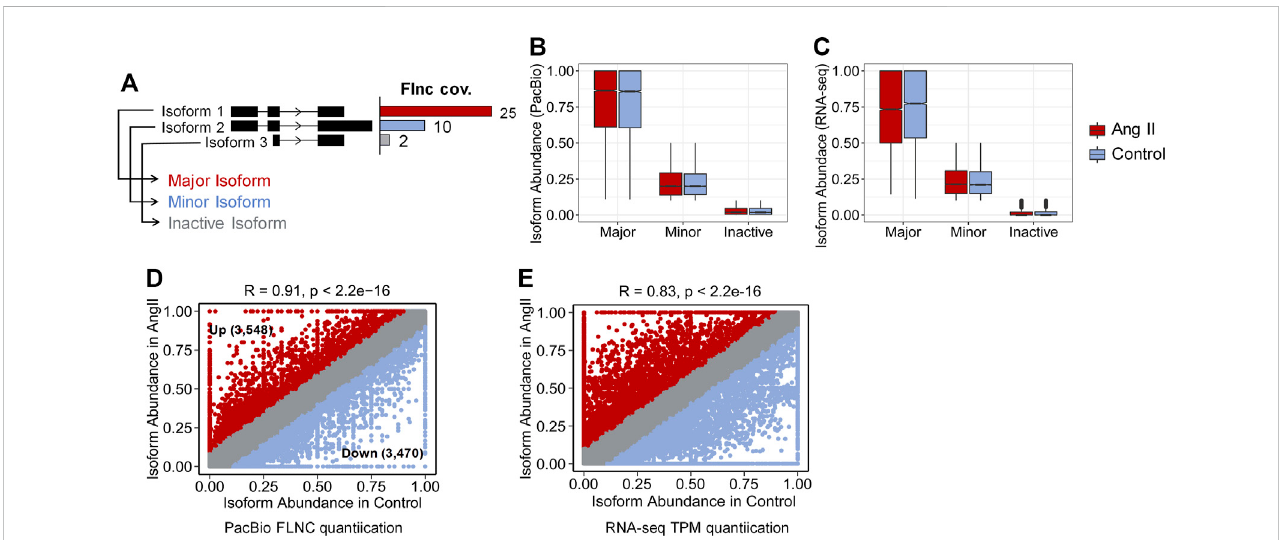
FIGURE 2 Isoform abundance changed between Control and Ang II. (A) Classi fi cation of isoform abundance according to the percentage of FLNC reads support. (B) Isoform abundance (PacBio quanti fi cation) distribution between Major, Minor and Inactive isoforms. (C) Isoform abundance (RNA-seq quanti fi cation) distribution between Major, Minor and Inactive isoforms. (D) Scatter plot of the isoform abundance between Ang II and control conditions (Iso-Seq quanti fi cation). (Up + Down)/(Total – Inactive) = (3,548 + 3,470)/(33,706 – 14,329) = 36.2%, Around 36.2% of the identi fi ed isoforms changed the proportion of usage before and after Ang II stimulation. (E) Scatter plot of the isoform abundance between Ang II and control conditions (RNA-seq quanti fi cation). Correlation of the isoform abundance (PacBio quanti fi cation) between Control and Ang II. The text in the fi gure indicates example genes.